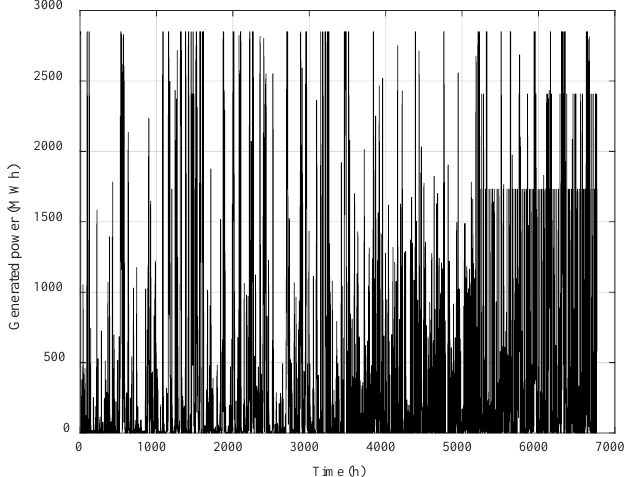
Figure 16. Hourly generated power of the wind